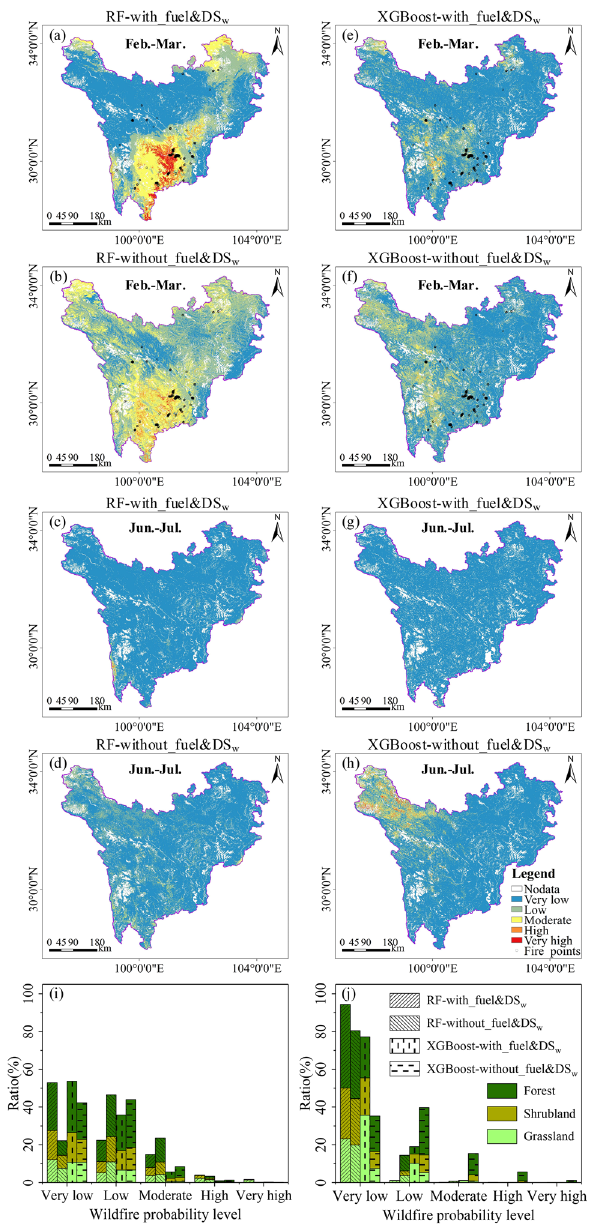
Fig. 4 Monthly average wildfire probability level distributions ( a - h ) and statistical coverage ( i , j ) in the fire seasons ( a , b , e , f , i , Febru- ary–March 2018) and nonfire seasons ( c , d , g , h , j , June–July 2018) for the study area based on the four models. The historical wildfire points shown on wildfire probability maps, occurring in February or March, were selected from the MODIS wildfire